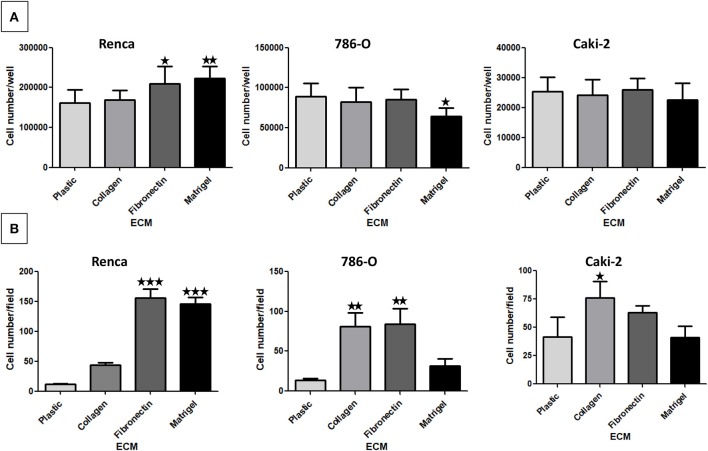
Effect of the different ECM components on RCC cell proliferation (A) and adhesion (B). (A) Renca, 786-O, and Caki-2 cells were cultured on uncoated (Plastic) or Col 1, FN1 or Matrigel coated dishes for 72 h. Then cells were detached and counted. Renca, N = 4; 786-O and Caki-2, N = 3. (B) Renca, 786-O, and Caki-2 cells were allowed to adhere on plastic, Col 1, FN1, or Matrigel for 1 h, fixed and nuclei labeled. Five photos per well were taken and nuclei counted using ImageJ software. N = 3. ⋆P < 0.05; ⋆⋆P < 0.01; ⋆⋆⋆P < 0.001.